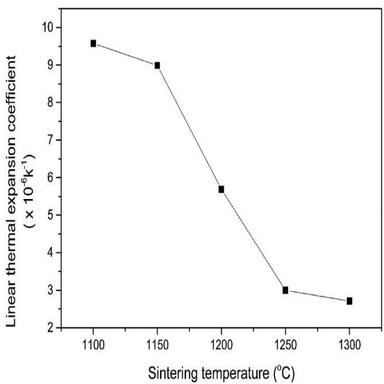
The linear coefficient of thermal expansion of the S-3 samples sintered at different temperatures for 2 h.